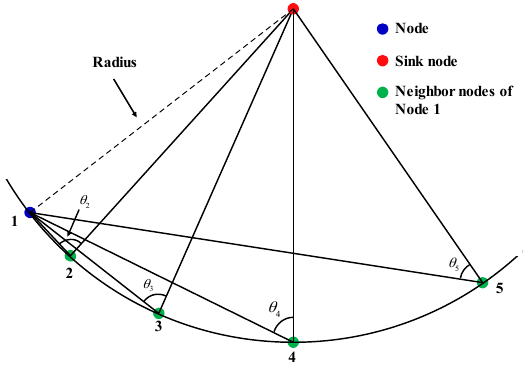
Figure 9. Node and neighbor nodes are on circumference of a circle, and the sink node is in the center of the circle.